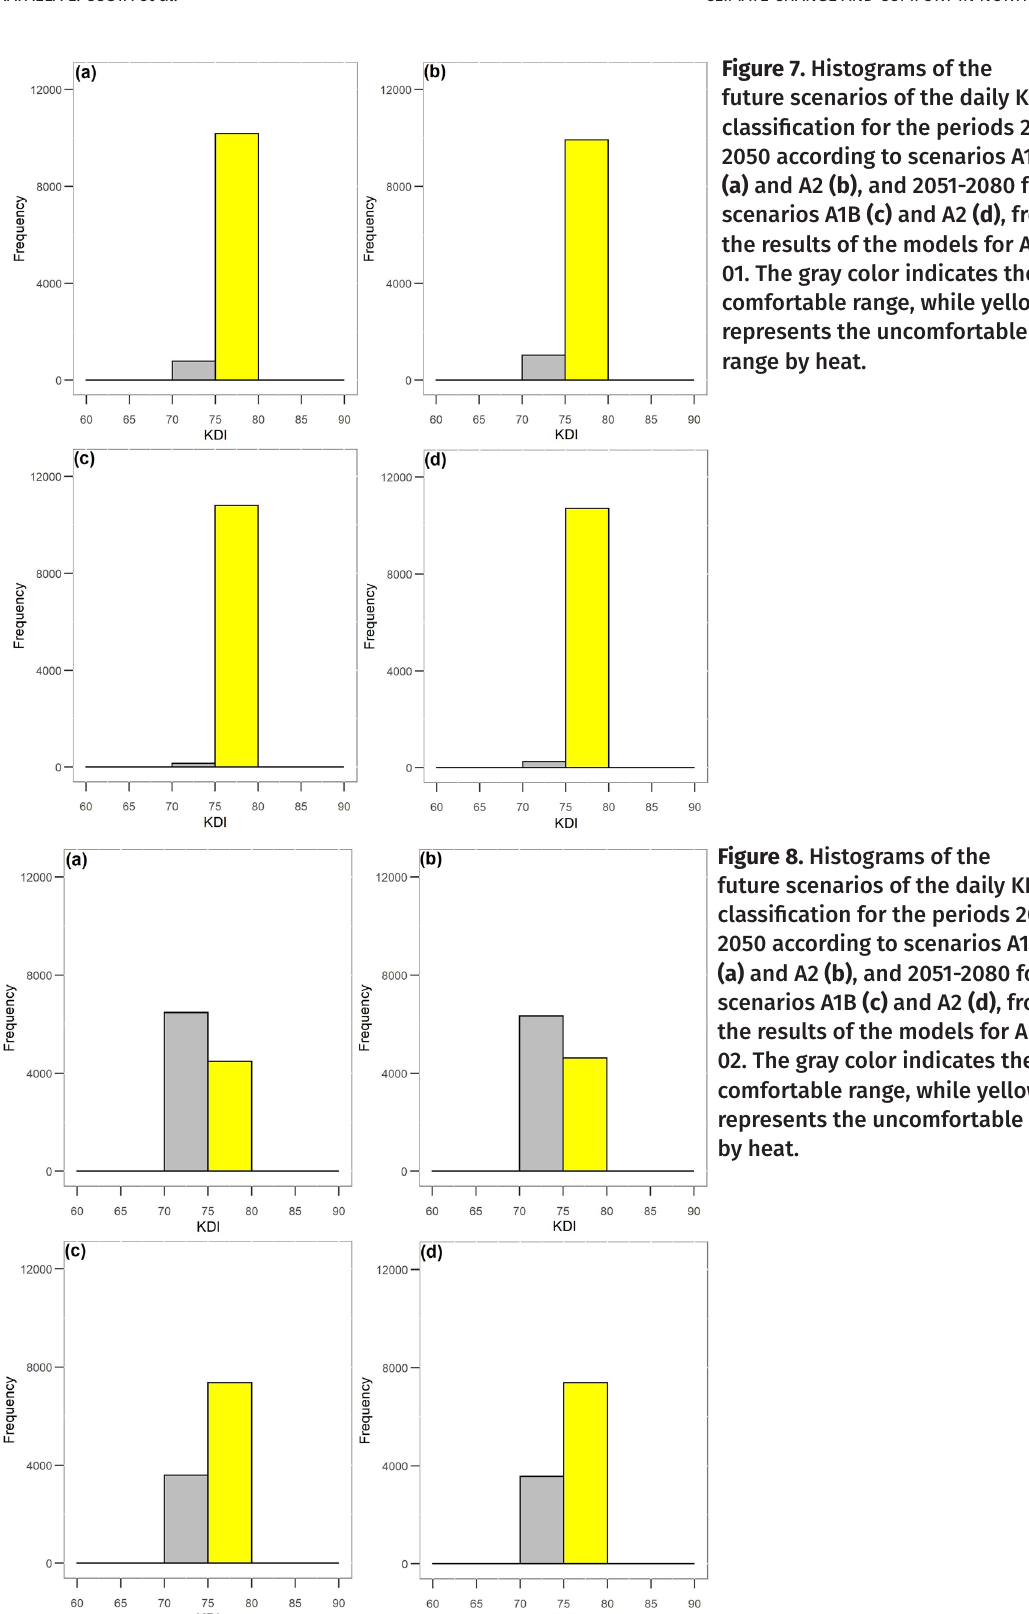
Figure 8. Histograms of the future scenarios of the daily KDI classification for the periods 2021- 2050 according to scenarios A1B (a) and A2 (b) , and 2051-2080 for scenarios A1B (c) and A2 (d) , from the results of the models for Area 02. The gray color indicates the comfortable range, while yellow represents the uncomfortable range by